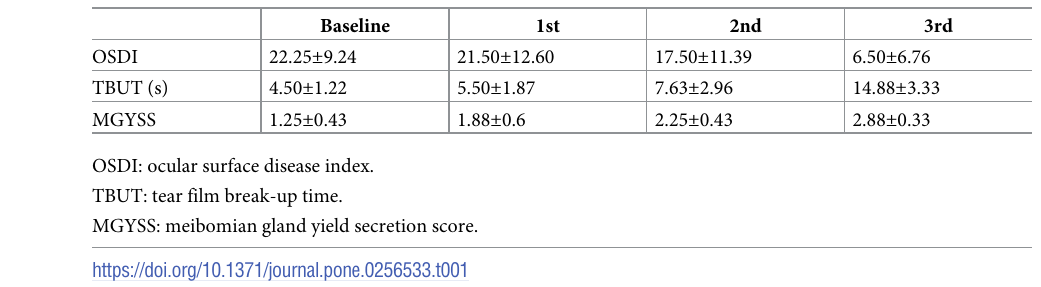
Table 1. Clinical evaluators following each IPL treatment session in patients with MGD.